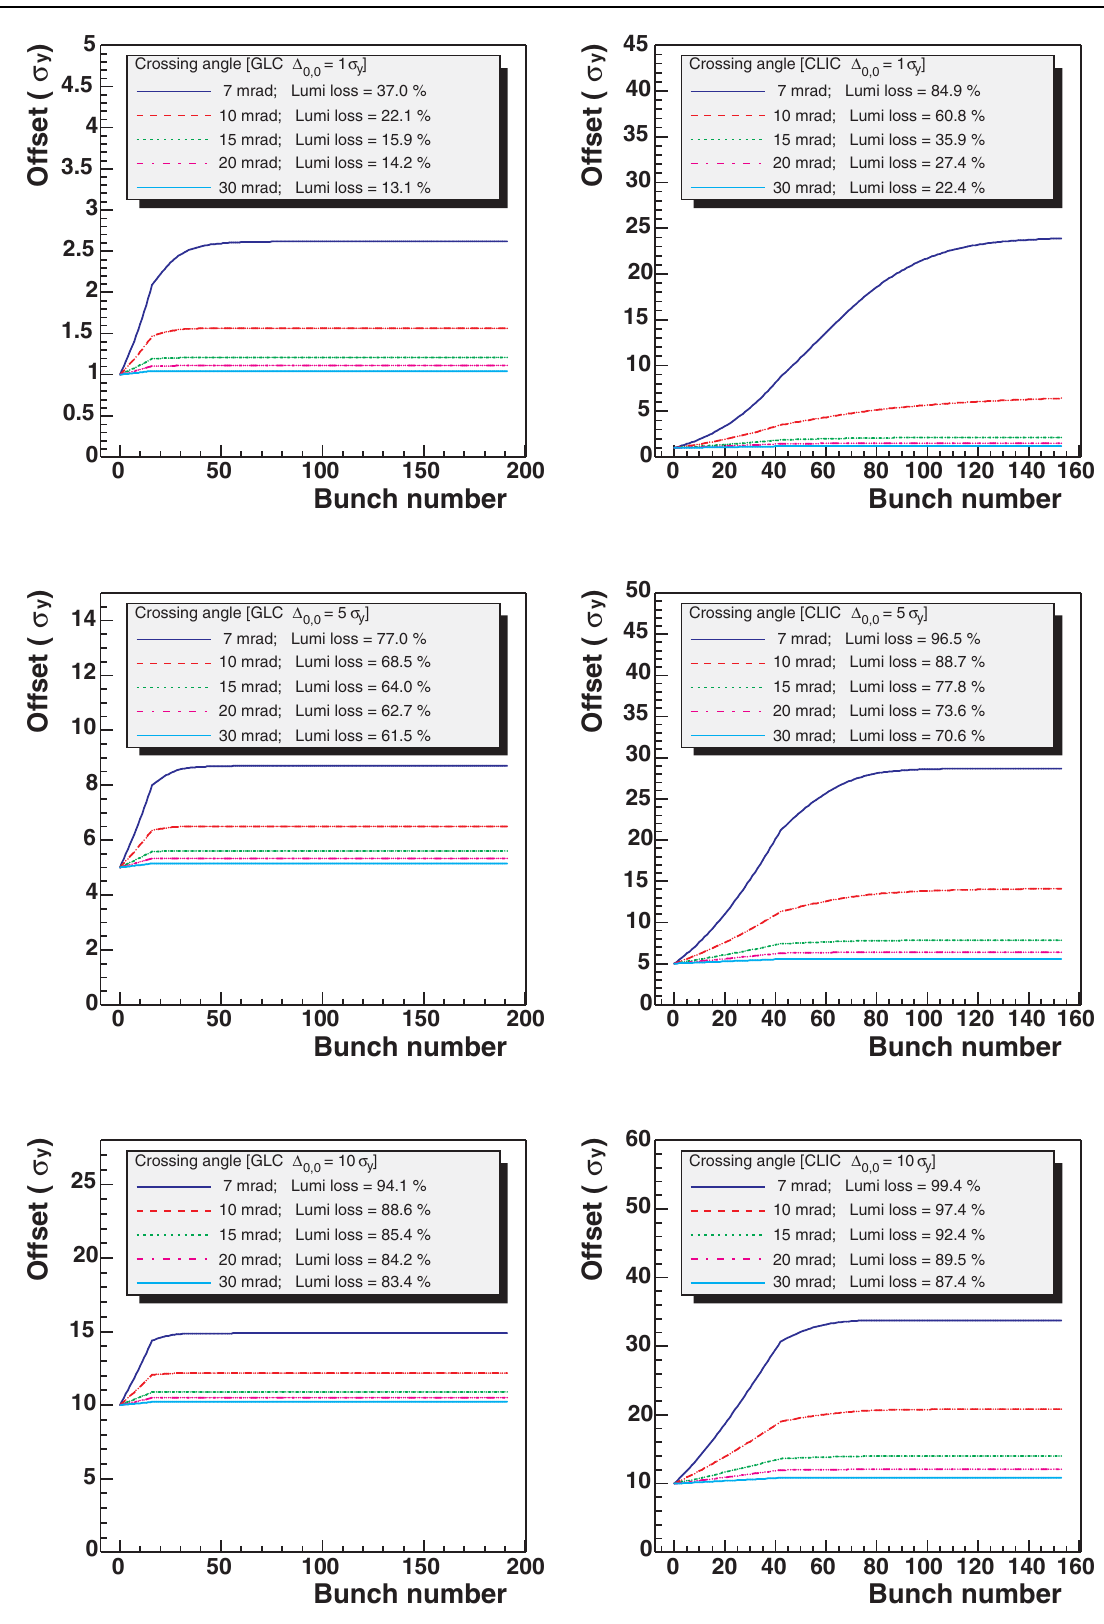
FIG. 3. (Color) Beam blowup as a function of the bunch number for an initial beam offset of 1 (cid:1) (lower plots) for different values of the crossing angle. The left column correspond to simulations with the GLC (NLC) 10 (cid:1) y parameters and the right column correspond to simulations with the CLIC